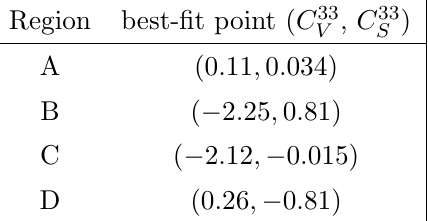
and C 33 corresponding to a good (cid:12)t to the R V S